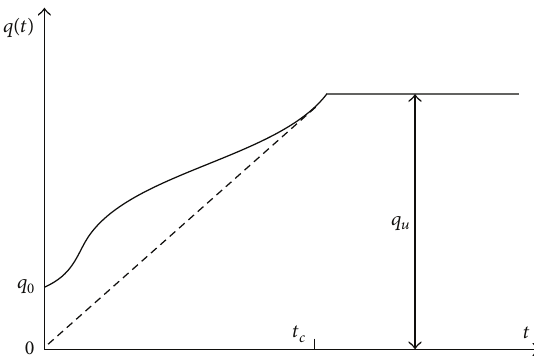
Figure 2: Time-dependent